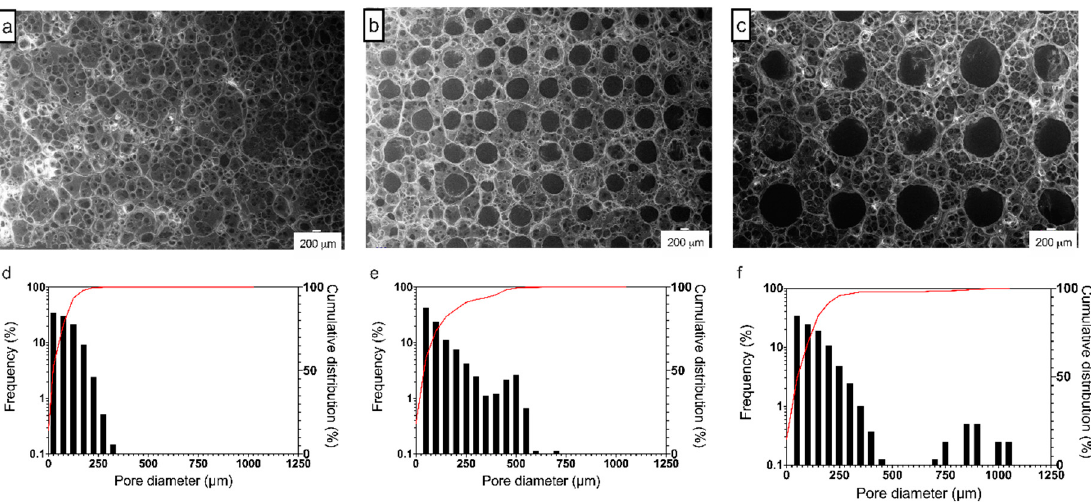
Figure 1. ( a – c ) Representative SEM micrographs and ( d – f ) frequency and cumulative distributions of pore dimension of ( a , d ) CPR, ( b , e ) CP500, and ( c , f ) CP1000 electrophoretic replica deposition (EPrD) chitosan patches. (SEM scale bar 200 µm.)